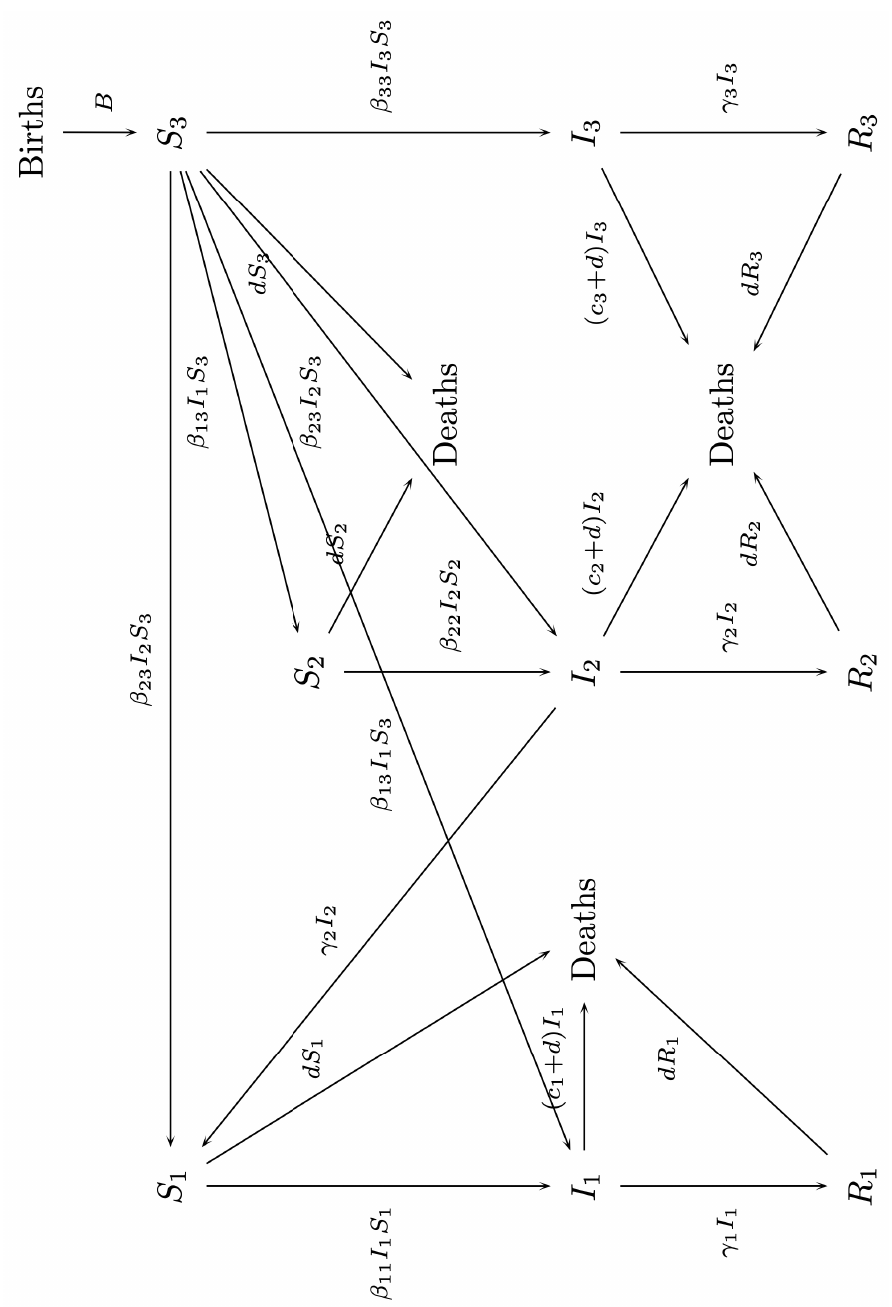
Figure 3. A diagram of the dynamics modeled by system